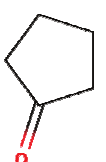
Fig. 1. Molecular Structure Cyclopentanone